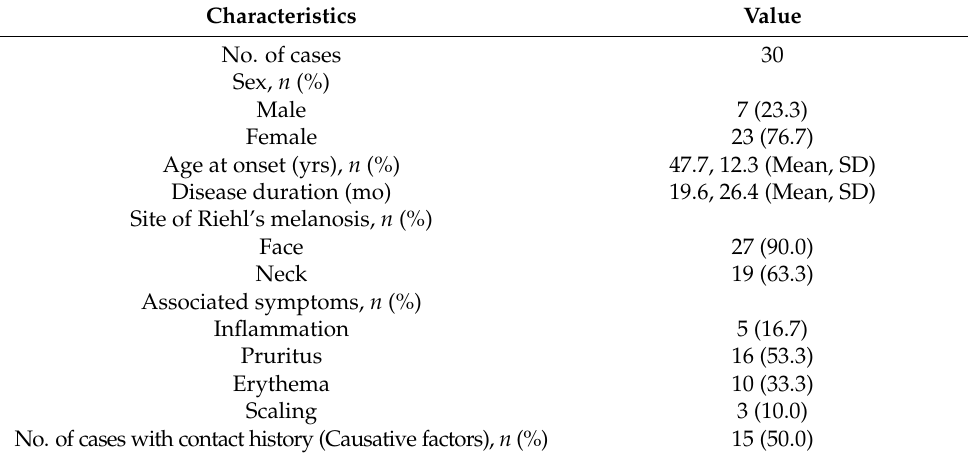
Table 1. Demographic data of patients with Riehl’s